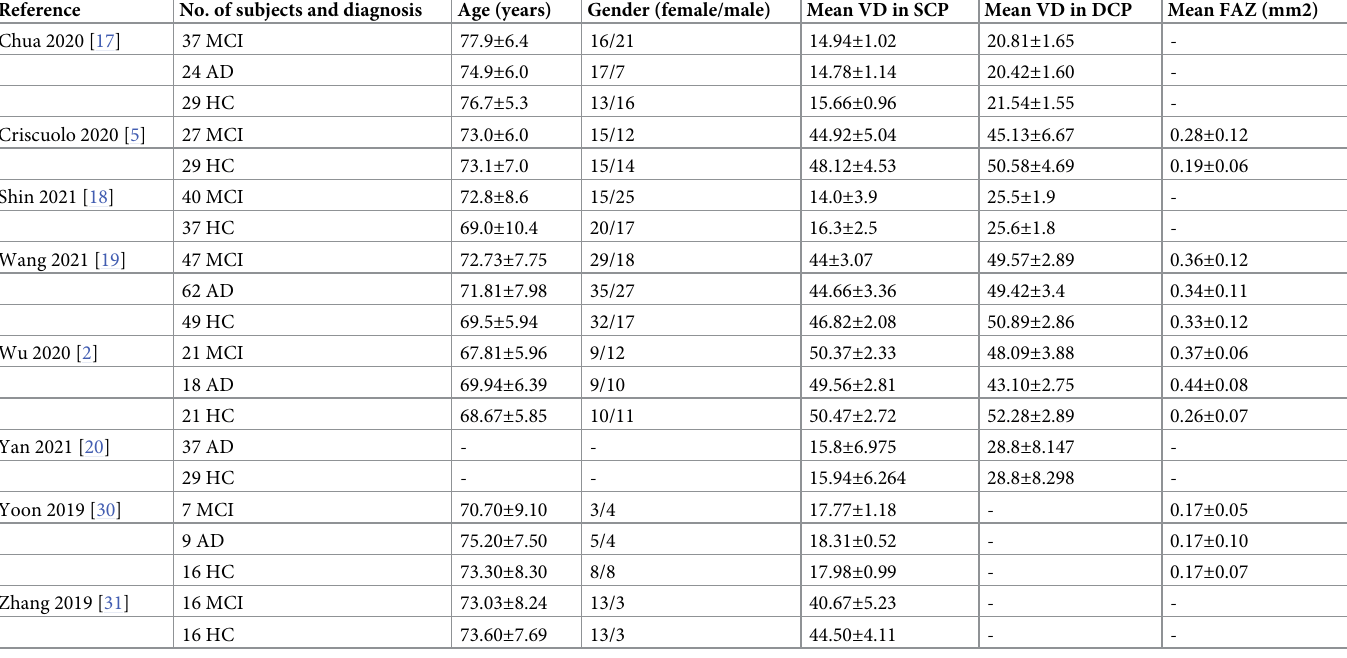
Table 1. Included studies using OCTA to assess the retinal microvasculature in Alzheimer’s disease (AD), mild cognitive impairment (MCI) patients and healthy controls (HC). Reference No. of subjects and